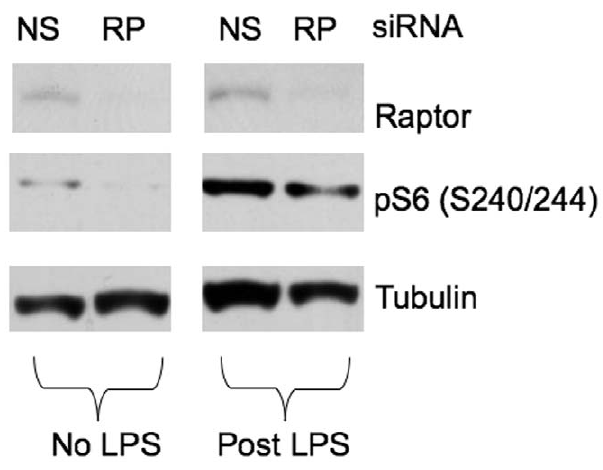
Figure 6. LPS activation of S6K was raptor dependent. RAW 264.7 cells were subjected to siRNA knockdown of raptor (RP), an essential component of mTORC1 or nonsense control (NS). Cells were then challenged with or without 100 ng/ml of LPS for 1 hr. Representative immunoblotsshownhere demonstrated theblunted LPS activation of S6K, as reflected by pS6 (S240/244) in cells subjected to raptor knockdown, supporting that mTORC1 activation by LPS led to S6K activation.